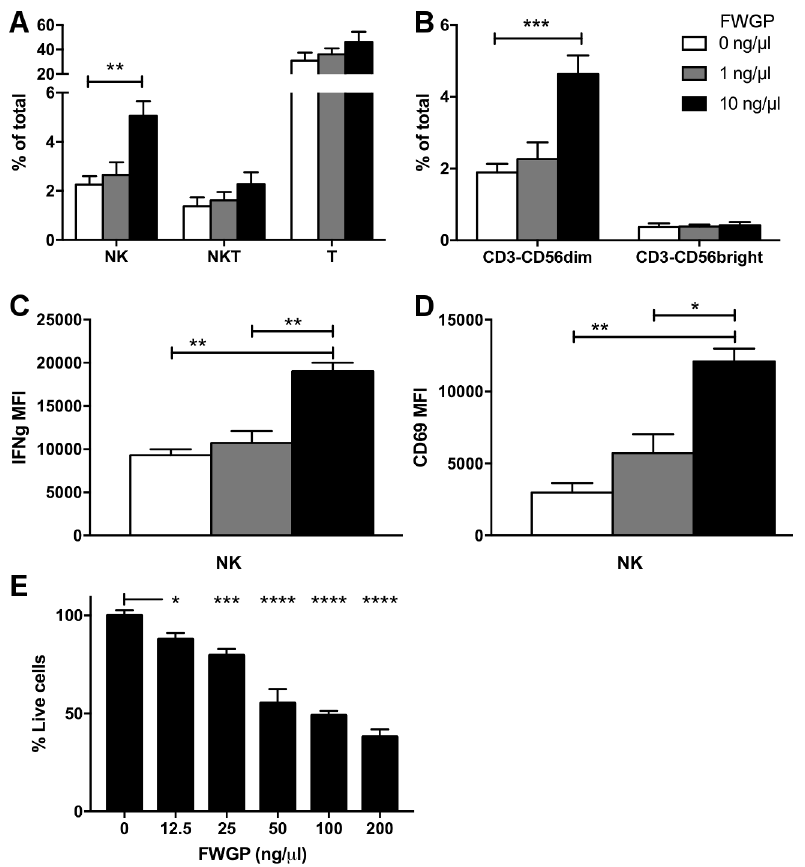
Fig 6. FWGP activates human NK cells ex vivo . PBMCs from healthydonors were incubatedwith FWGP (at the indicatedconcentrations) or medium only (control) for 16 h. (A) NK (CD3 - CD56 + ), NKT (CD3 + CD56 + ) and T (CD3 + CD56 - ) populationsas % of total live cells. (B) CD56 dim and CD56 bright subpopulations as % of total live cells (n = 3; ** p < 0.01, *** p < 0.001; 2-way ANOVA with Tukey’s multiplecomparisontest). NK cell activationwas assessedas medianfluorescence intensity of IFN γ (C) and CD69 (D) in the CD3 - CD56 + population (n = 3; * p < 0.05, ** p < 0.01;ANOVA with Dunnet’smultiplecomparisontest). (E) Killingactivity againstRamos cells at E:T = 1:1. Bars indicatethe mean ± SDof % live cells after 24 h contact time, relative to Ramos cells incubatedwith untreatedPBMCs controls (n = 3; * p < 0.05, *** p < 0.001, **** p < 0.0001; ANOVA with